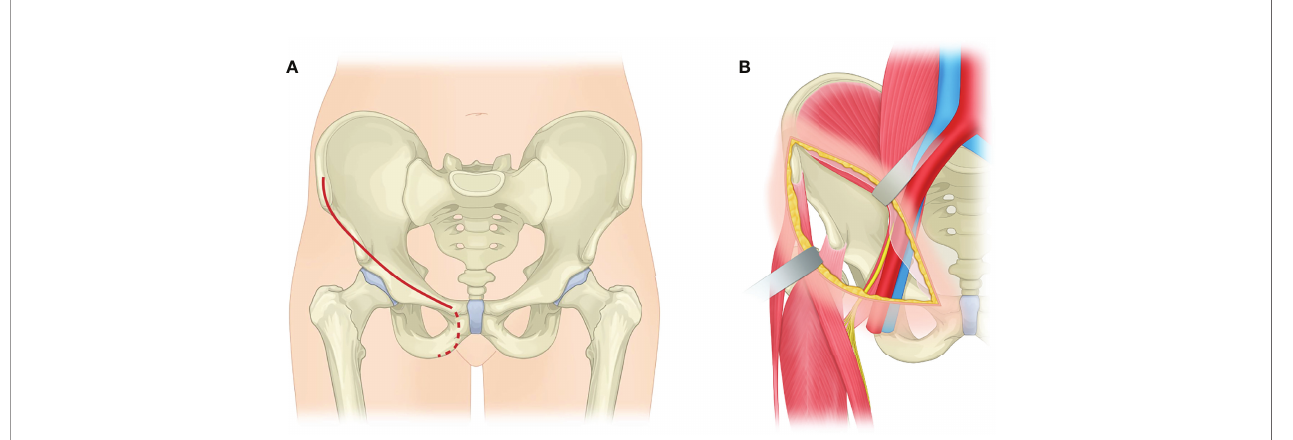
FIGURE 2 | Schematic depiction of the modi fi ed ilioinguinal approach. (A) The ilioinguinal incision (red solid line) is shown. The incision can extend following the inferior pubic ramus (red dotted line) to exposed peri-obturator region, if needed. (B) The image shows the exposure to the inner surface of the innominate bone via a modi fi ed ilioinguinal approach. The iliopsoas is relaxed by upshifting the femur and is retracted to access the iliopectineal arch.